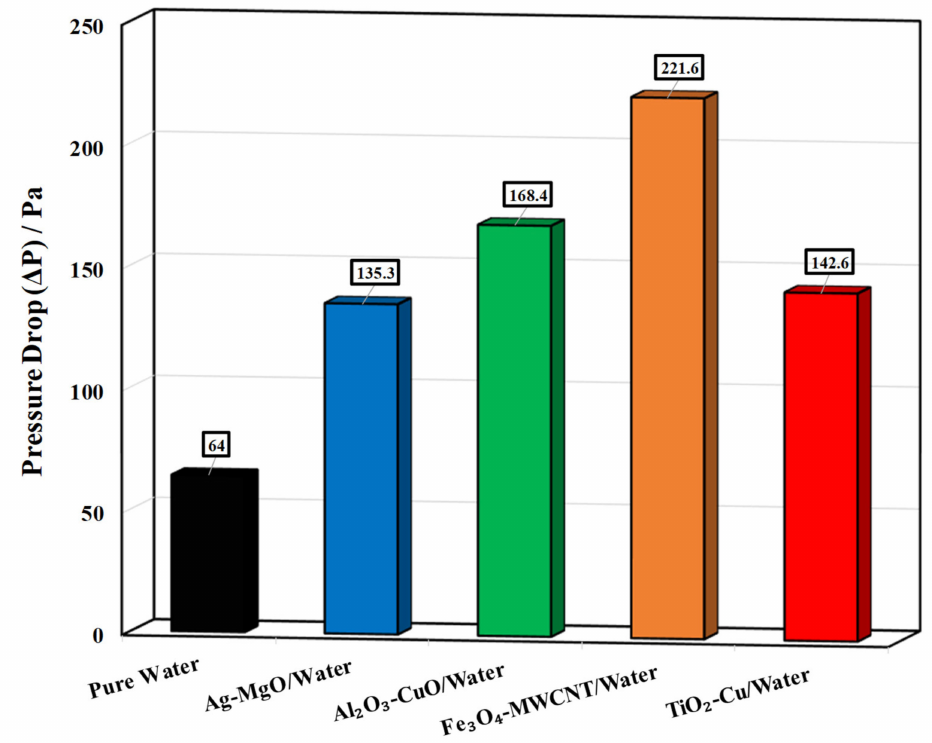
Figure 7. Pressure drop for various hybrid nanofluids at φ = 0.15 and Re = 3200. COP improvement for various hybrid nanofluids at φ = 0.15 and Re = 3200 is